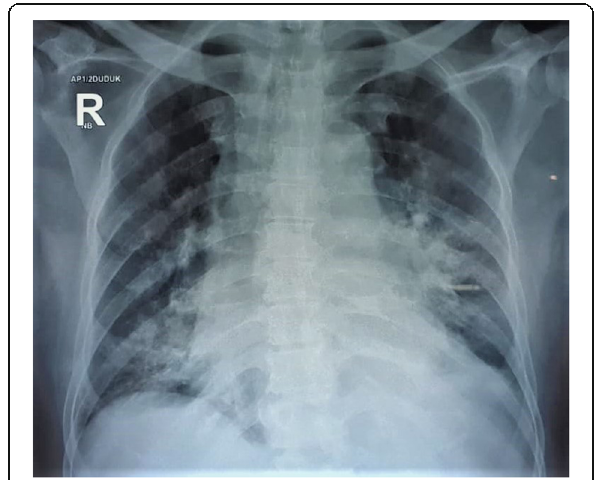
Fig. 2 Chest X-ray showed preceding consolidation persisted with new consolidative changes in the left apical-middle-lower zone and the right lower peripheral region